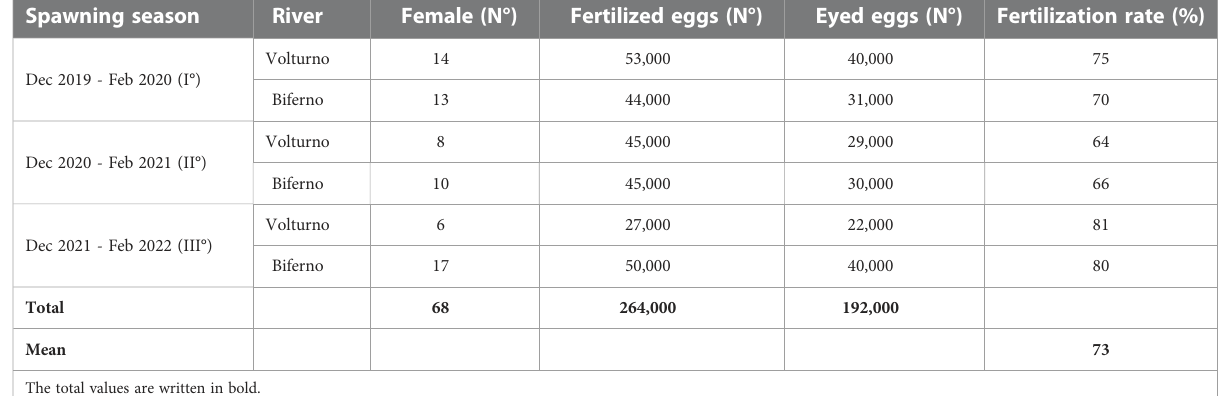
TABLE 2 Number of fertilized and eyed eggs and fertilization ability recorded with frozen semen, along the spawning